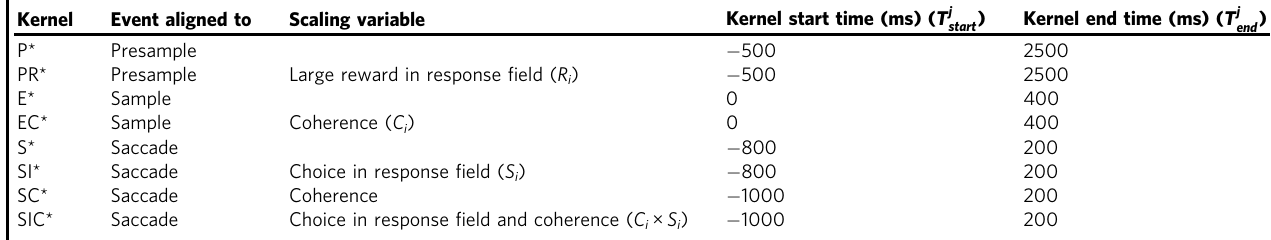
Table 2 Constants de fi ning the regression kernels for the modi fi ed regression